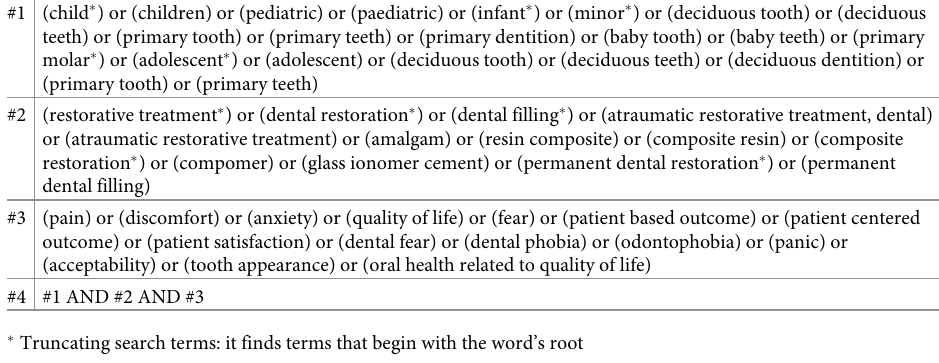
Table 1. Search strategy developed for MEDLINE via PubMed. #1 (child � ) or (children) or (pediatric) or (paediatric) or (infant � ) or (minor � ) or (deciduous tooth) or (deciduous teeth) or (primary tooth) or (primary teeth) or (primary dentition) or (baby tooth) or (baby teeth) or (primary molar � ) or (adolescent � ) or (adolescent) or (deciduous tooth) or (deciduous teeth) or (deciduous dentition) or (primary tooth) or (primary teeth) #2 (restorative treatment � ) or (dental restoration � ) or (dental filling � ) or (atraumatic restorative treatment, dental) or (atraumatic restorative treatment) or (amalgam) or (resin composite) or (composite resin) or (composite restoration � ) or (compomer) or (glass ionomer cement) or (permanent dental restoration � ) or (permanent dental filling) #3 (pain) or (discomfort) or (anxiety) or (quality of life) or (fear) or (patient based outcome) or (patient centered outcome) or (patient satisfaction) or (dental fear) or (dental phobia) or (odontophobia) or (panic)